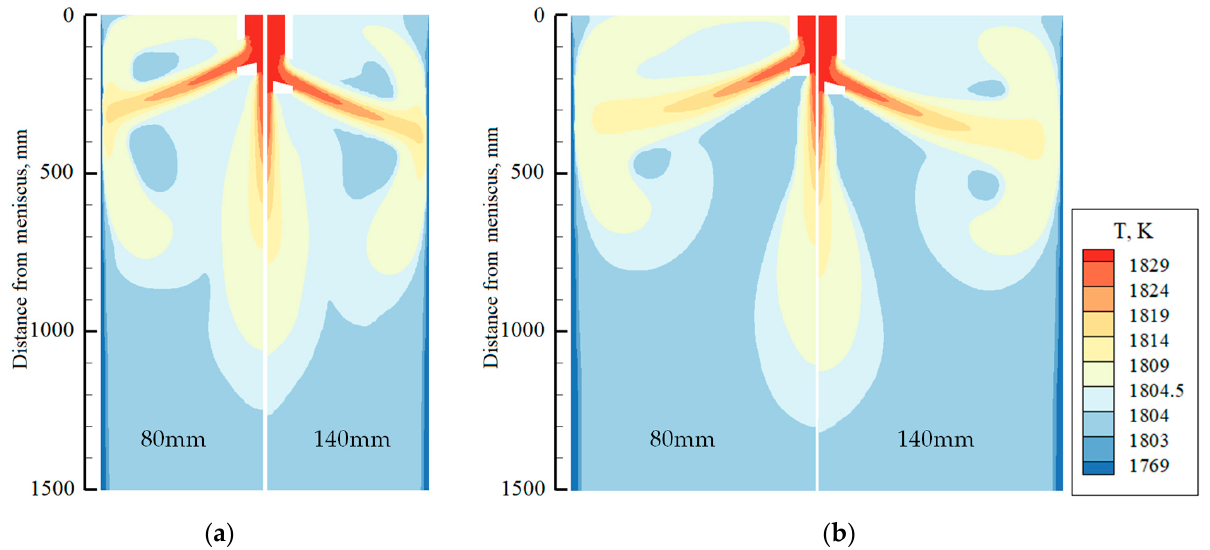
Figure 6. Calculated temperature distribution at the central-symmetrical plane with different submergence depths for the mold width of ( a ) 1020 mm and ( b ) 1540 mm.